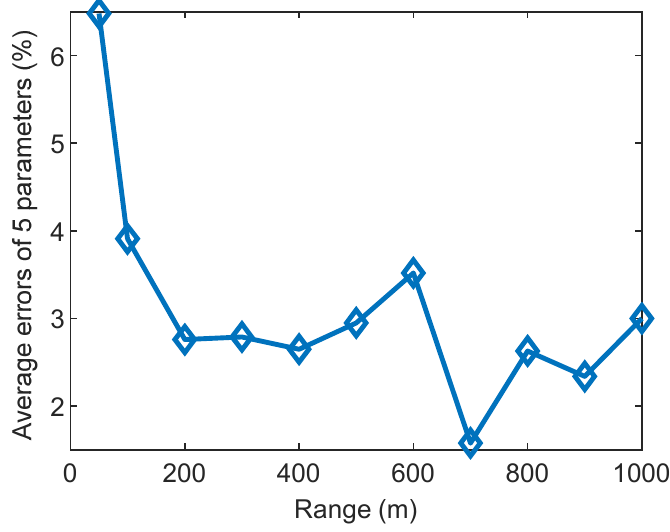
Figure 13. The change process of average errors of five parameters with different ranges.